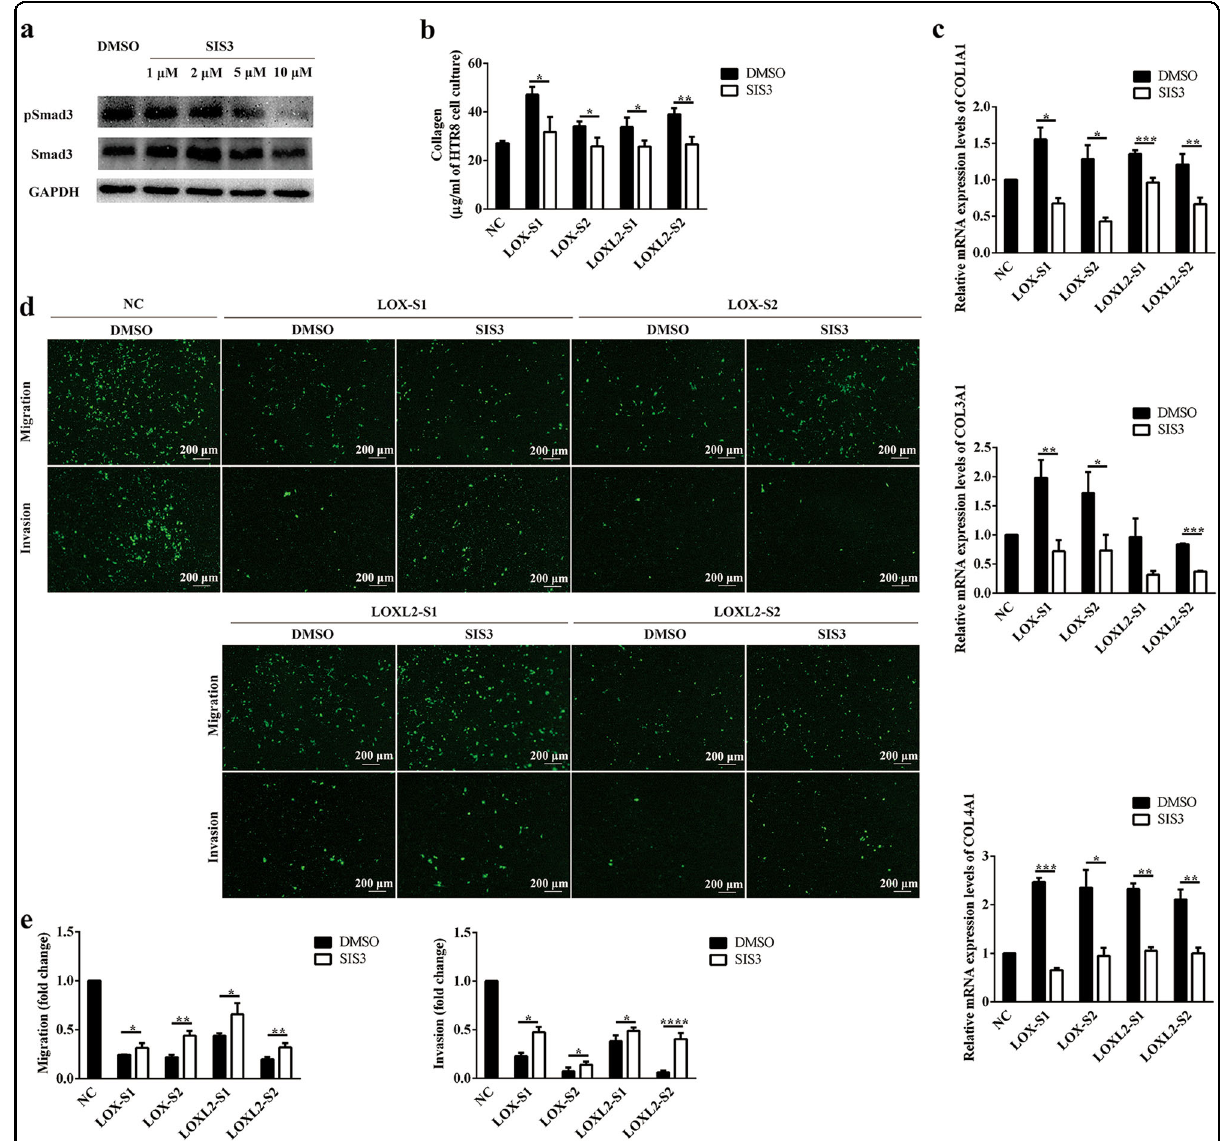
Fig. 5 Inhibiting Smad3 could partially rescue trophoblast cell migration and invasion. a Western blot analysis of pSmad3 and Smad3 in HTR- 8/SVneo cells treated with the Smad3 inhibitor SIS3 (0, 2, 5, or 10 μ mol/L) for 24 h. b Amount of soluble collagen in culture supernatants from HTR-8/ SVneo cells transfected with small interfering RNA (siRNA) followed by SIS3 treatment (10 μ mol/L) was quanti fi ed using a sircol collagen assay. c Quanti fi cation of COL1A1 , COL3A1 , and COL4A1 mRNA expression levels was determined in HTR-8/SVneo cells upon siRNA transfection followed by SIS3 treatment (10 μ mol/L). d Migration and invasion of HTR-8/SVneo cells upon siRNA transfection followed by SIS3 treatment (10 μ mol/L) was determined by Transwell assays. Representative images are shown. e Relative fold changes in cell migration and invasion were calculated. Statistical data were analyzed by Student ’ s t -test. Data are presented as the means ± SEM of three independent experiments. * P < 0.05; ** P < 0.01; *** P < 0.001; and **** P <